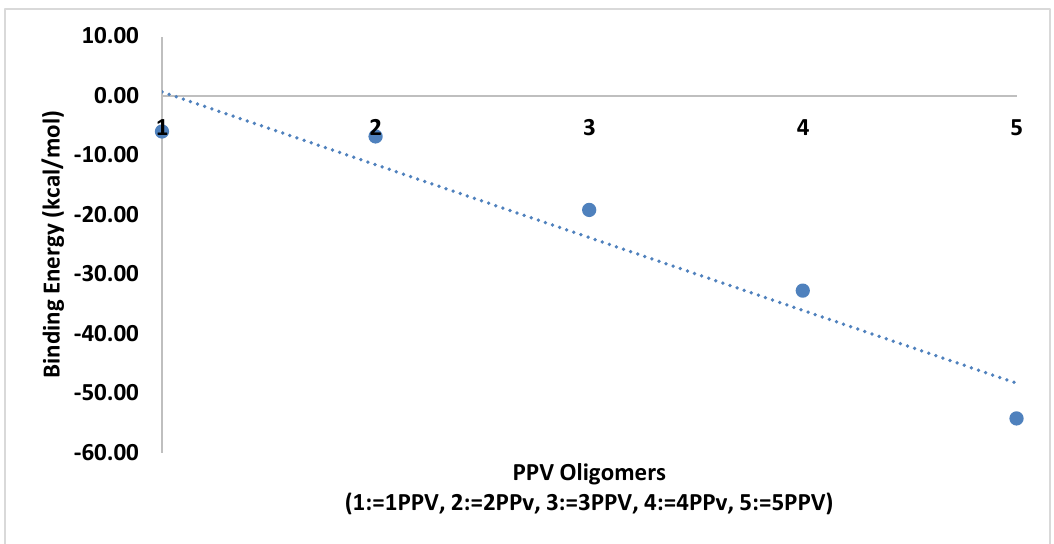
Figure 20. Binding energy PPV oligomers–graphene.